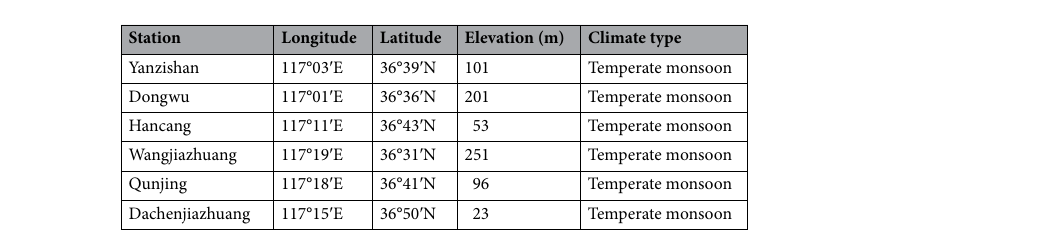
Table 1. Weather station locations and climate